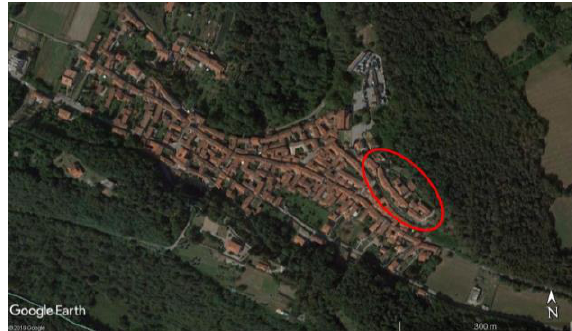
Figure 2. Position of the hamlet in the Magnano village (after Google Earth, modified).